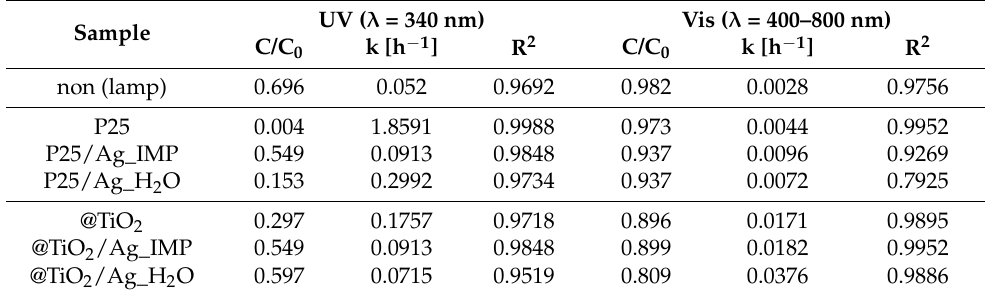
Table 3. Kinetic parameters of first kinetic order model determined for photocatalytic oxidation of 4NP using UV and Vis source on @TiO 2 and P25 materials before and after deposition of Ag using two different methods—IMP and H 2